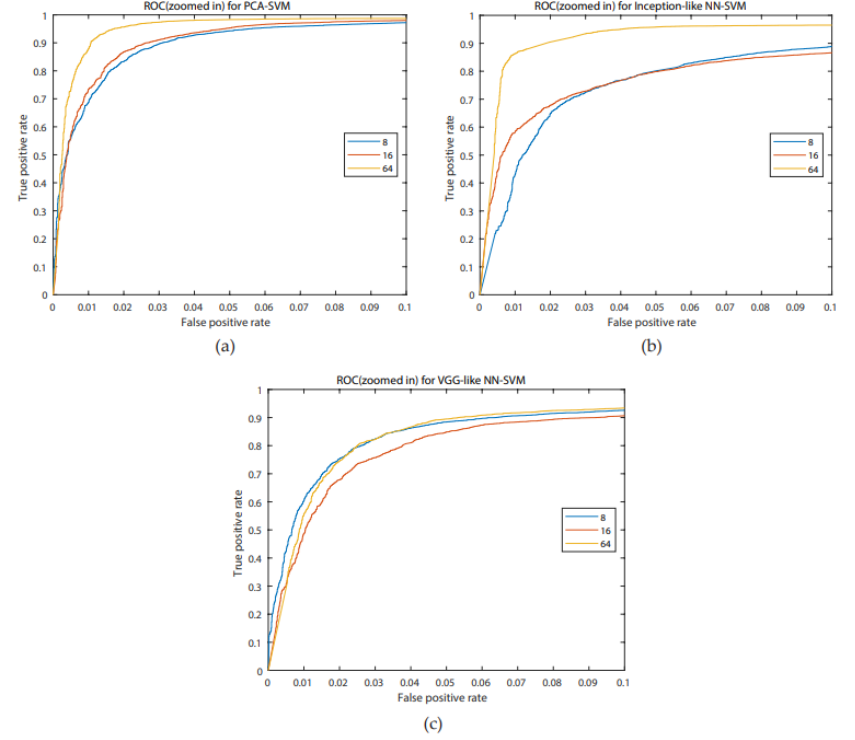
Figure 9. ROC curves for the PCA-SVM (blue), inception-like NN-SVM (red), VGG-like NN-SVM (yellow) for a false positive rate (FAR) ranging from 0 to 0.1 to emphasize differences ranging from 0 to 0.1 for 8 channels ( a ), 16 channels ( b ), 64 channels ( c ).